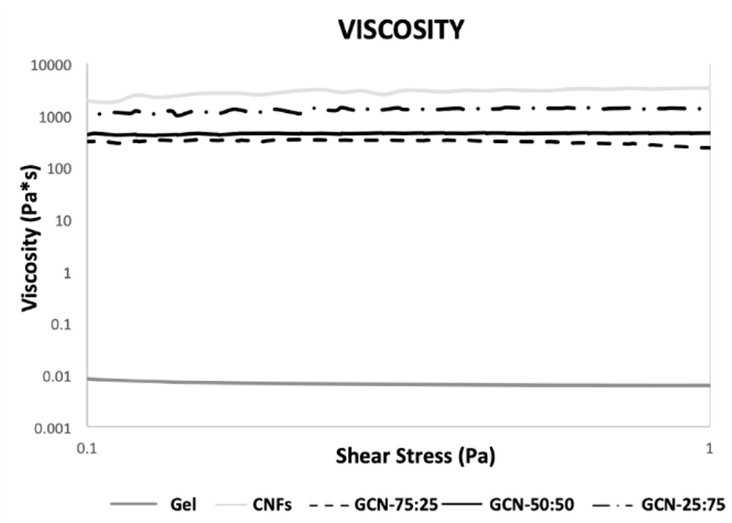
Figure 3. Viscosity behavior of the biocomposites and the pure materials.